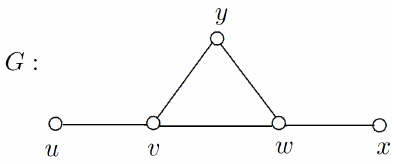
Figure 4: A graph G with no regular total dominating